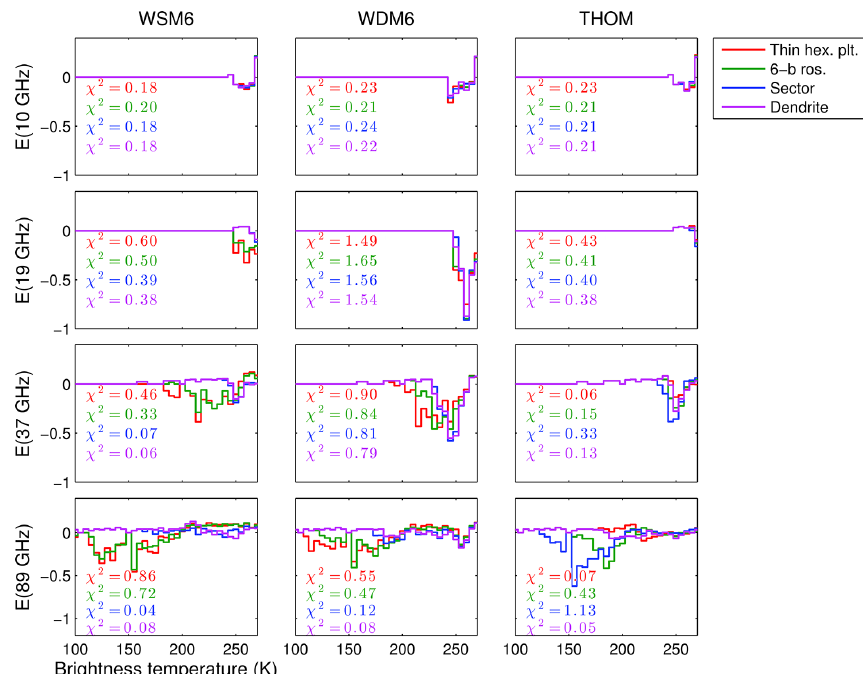
Figure 12. The simulated (solid coloured lines) residuals of the χ 2 test for the TMI brightness temperature distributions. Note that the χ 2 value is included for each of the DDA habit simulated distributions calculated from all temperature bins below 270K.